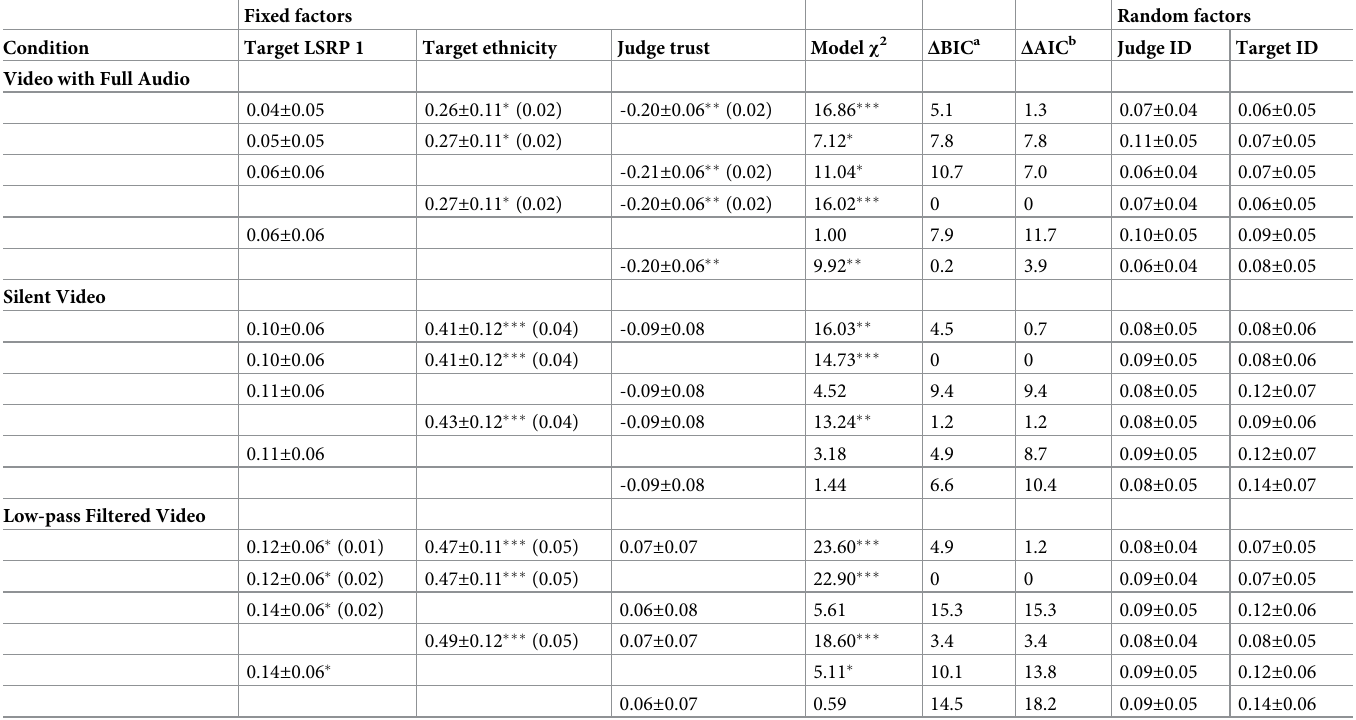
Table 5. Multilevel mixed regression models predicting Levenson other-report secondary psychopathy judgments (LORP F2). Fixed factors Random factors